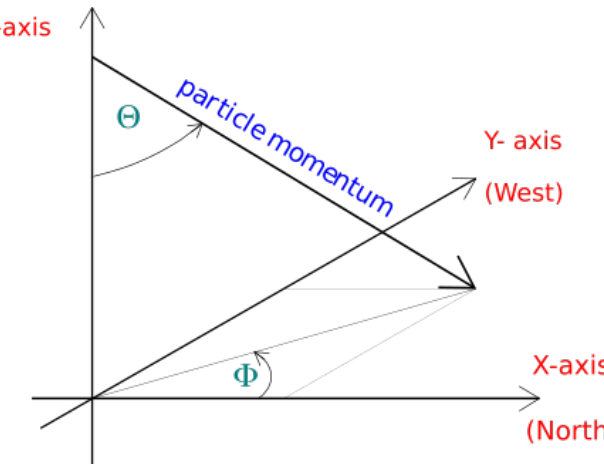
Figure 3. CORSIKA’s coordinate system used